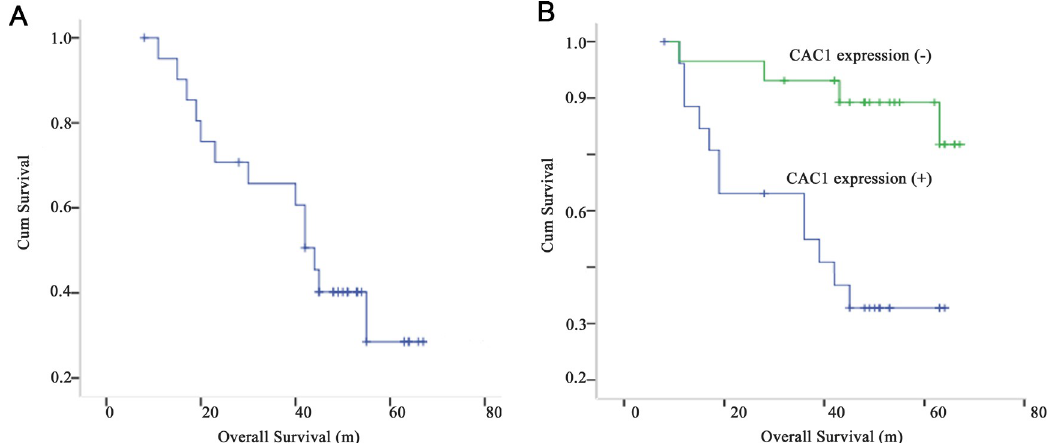
Fig 2. The overall survival curve of colorectal cancer patients with different CAC1 expression. (A) The overall survival curve of the 83 enrolled patients. (B) The overall survival curves of patients with CAC1 positive expression and CAC1 negative expression. (Fig 3A). The efficiency of CAC1 knockdown in SW480-shCAC1 and SW480/5FU-shCAC1 cells was confirmed at both the protein and mRNA level (Fig 3B and 3C).